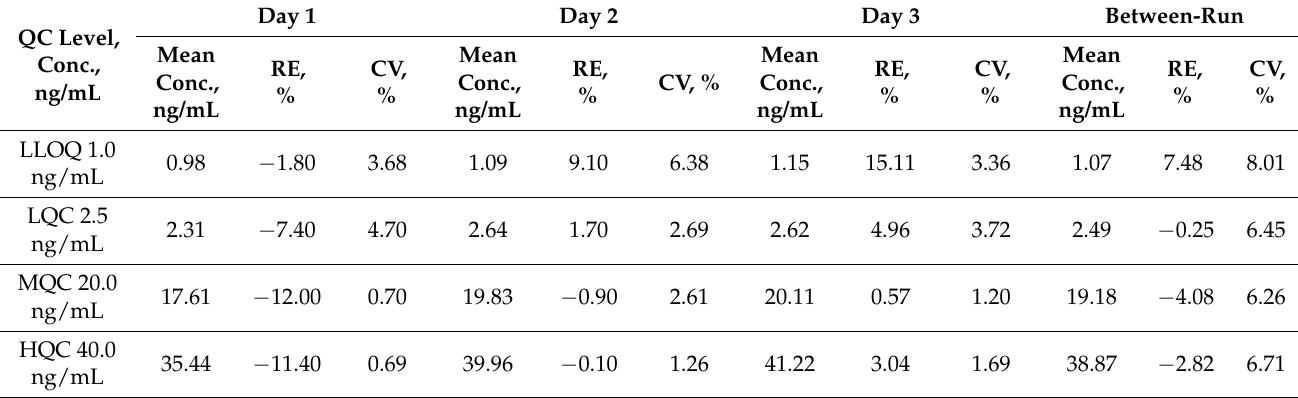
Table A6. Accuracy and precision data for AML.